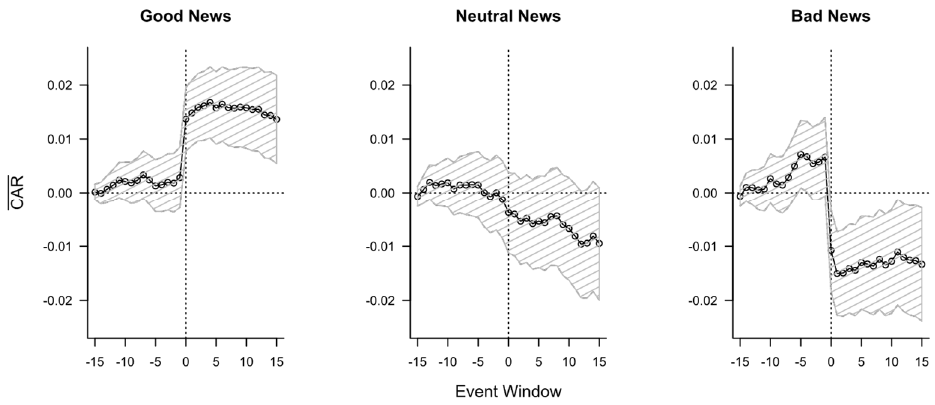
Figure 2. Evolution of 𝐶𝐴𝑅 (cid:3364)(cid:3364)(cid:3364)(cid:3364)(cid:3364)(cid:3364) (cid:3047) for all news classes with 95 percent confidence intervals. Figure 2. Evolution of CAR t for all news classes with 95 percent confidence intervals. Figure 2. Evolution of 𝐶𝐴𝑅(cid:3364)(cid:3364)(cid:3364)(cid:3364)(cid:3364)(cid:3364) (cid:3047) for all news classes with 95 percent confidence intervals.